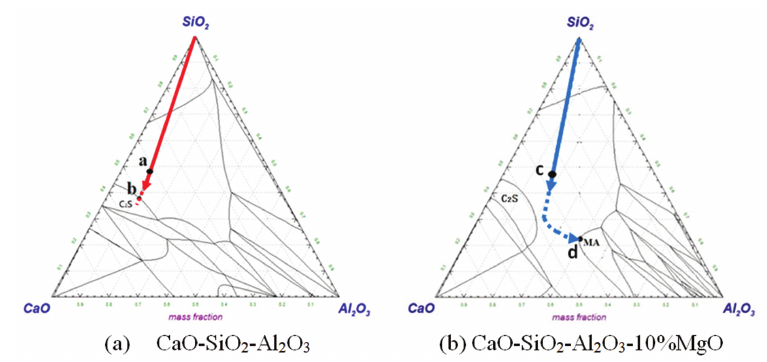
Figure 9: CaO-Al 2 O 3 -SiO 2 -(10% MgO) isothermal phase diagram at 1773K